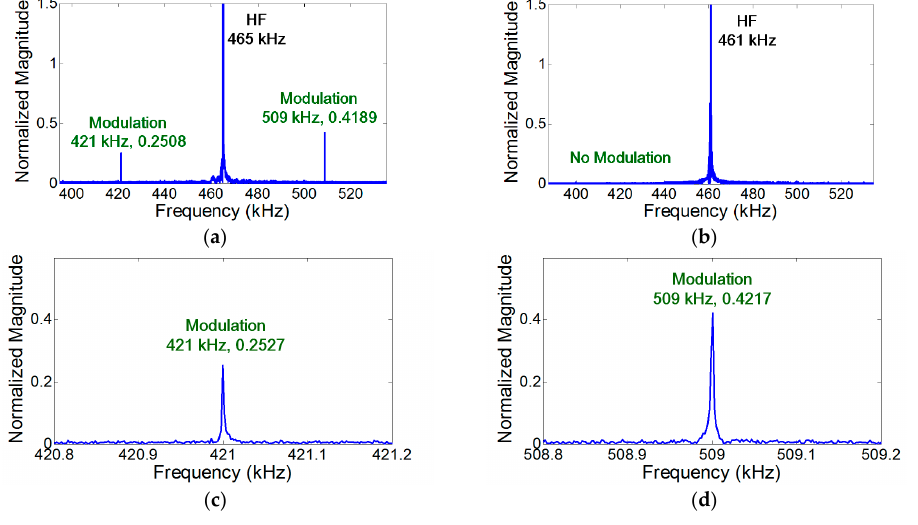
Figure 4. Experimental validation of the crack perturbation condition. The modulation occurs only when the crack is located at the anti-nodes of both LF and HF vibration modes. Here, S 0 modes are excited at both LF and HF inputs, and the synchronism condition is avoided to minimize the effect of distributed material nonlinearity. ( a ) Crack is located at the anti-nodes of both LF (44 kHz) and HF (465 kHz) vibration modes; ( b ) Crack is located at the nodes of both LF (46 kHz) and HF (461 kHz) vibration modes; ( c ) Close-up of (a) near 421 kHz; ( d ) Close-up of (a) near 509 kHz.